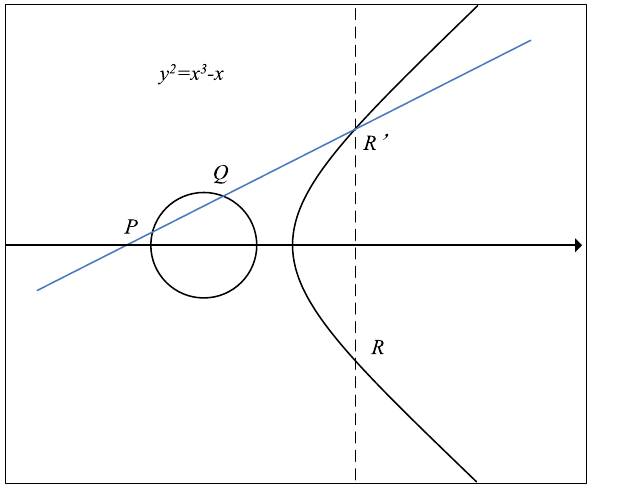
Figure 1. P + Q = R in